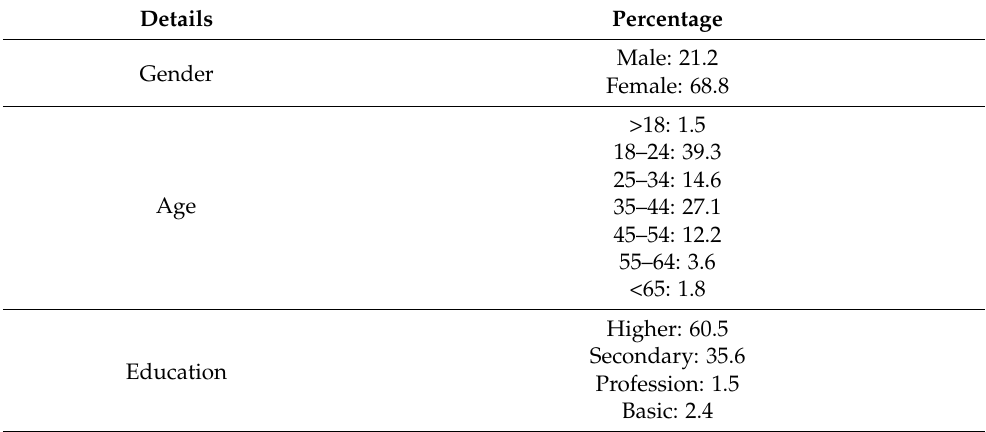
Table 2. Demographic characteristic